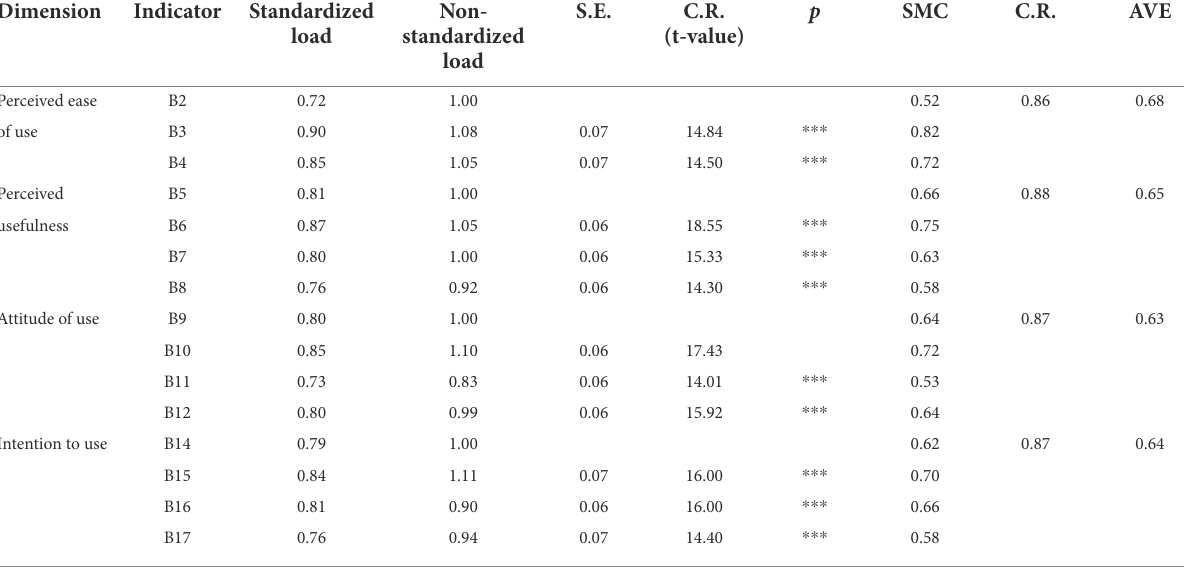
TABLE 2 Technology acceptance model - confirmatory factor analysis.